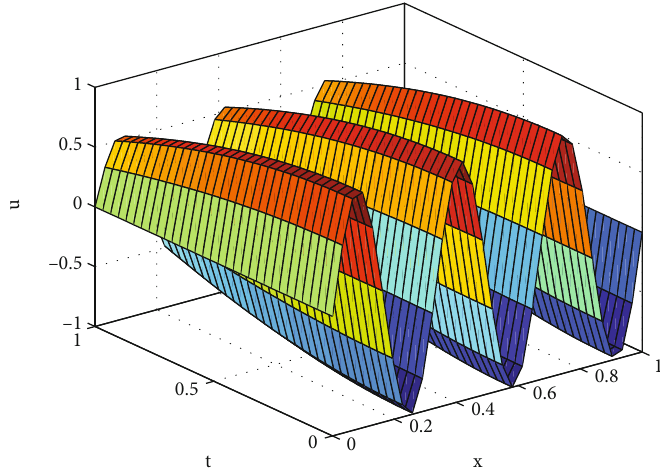
Figure 6: Analysis solutions of u ð x , t Þ = cos ð t Þ sin ð 6 π x Þ